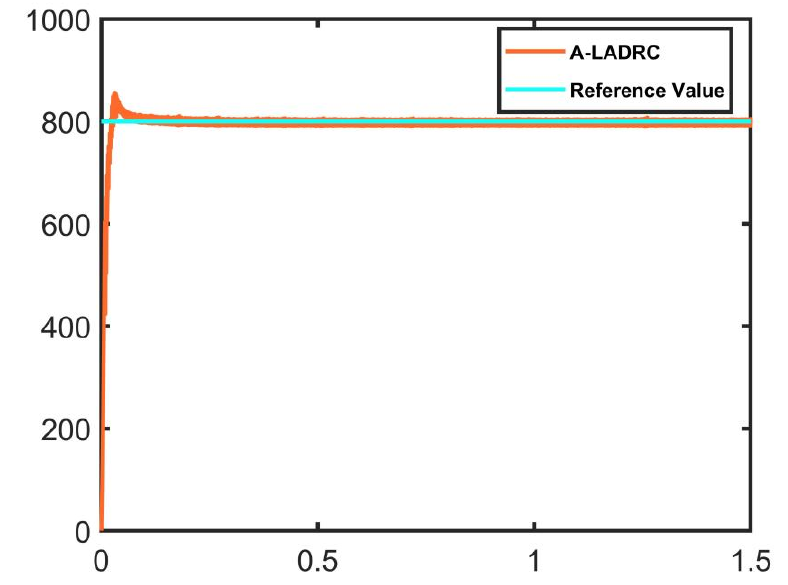
Figure 4. DC bus voltage waveform of A–LADRC.